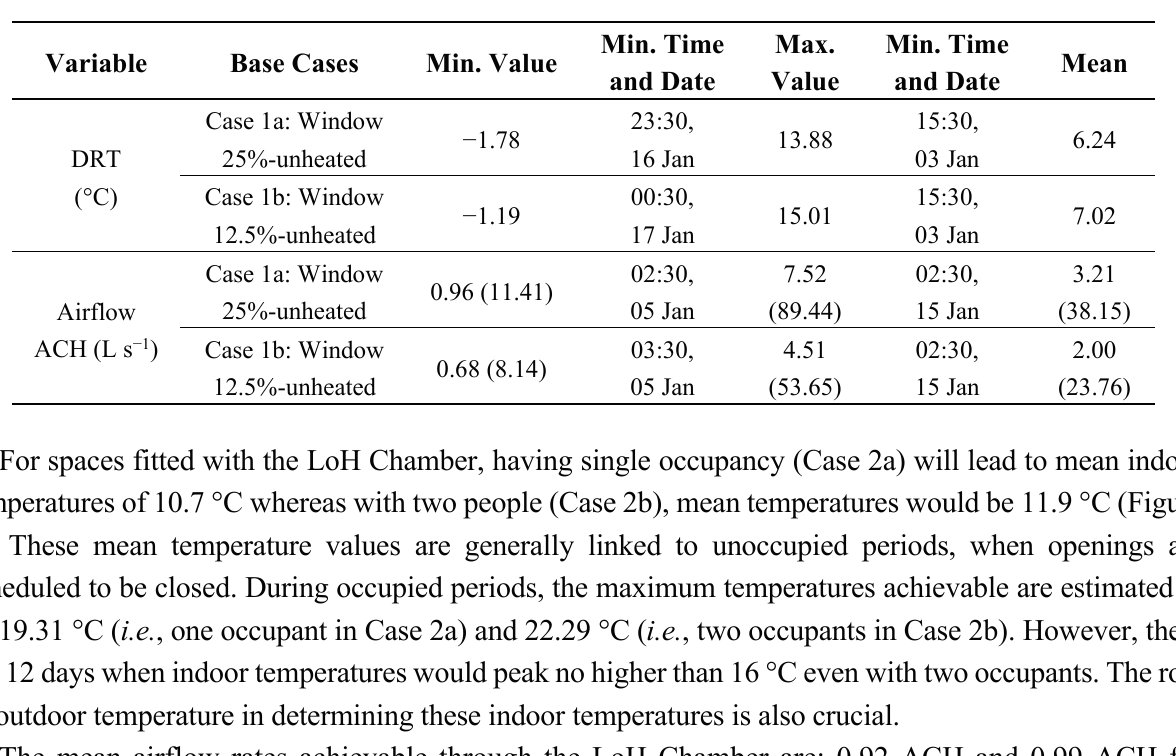
Figure 7. Predicted monthly airflow rates into the unheated base cases (Cases 1a and 1b). Table 2. Summary of minimum, maximum and mean values for DRT and Airflow rates in Base